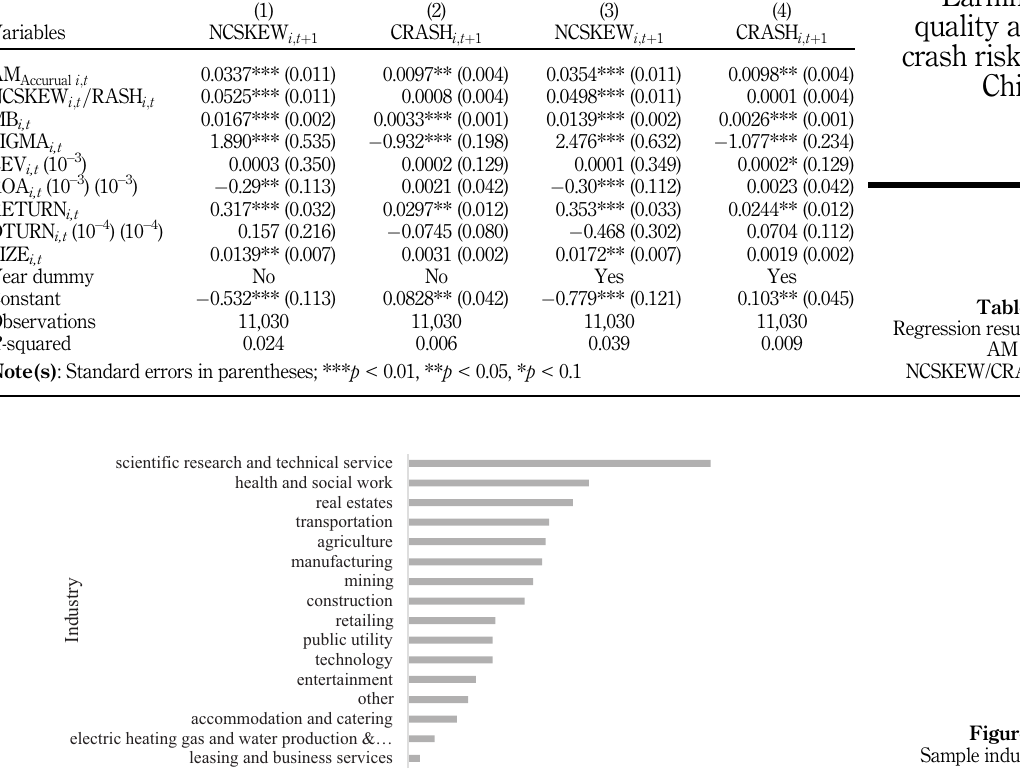
Figure 1. Sample